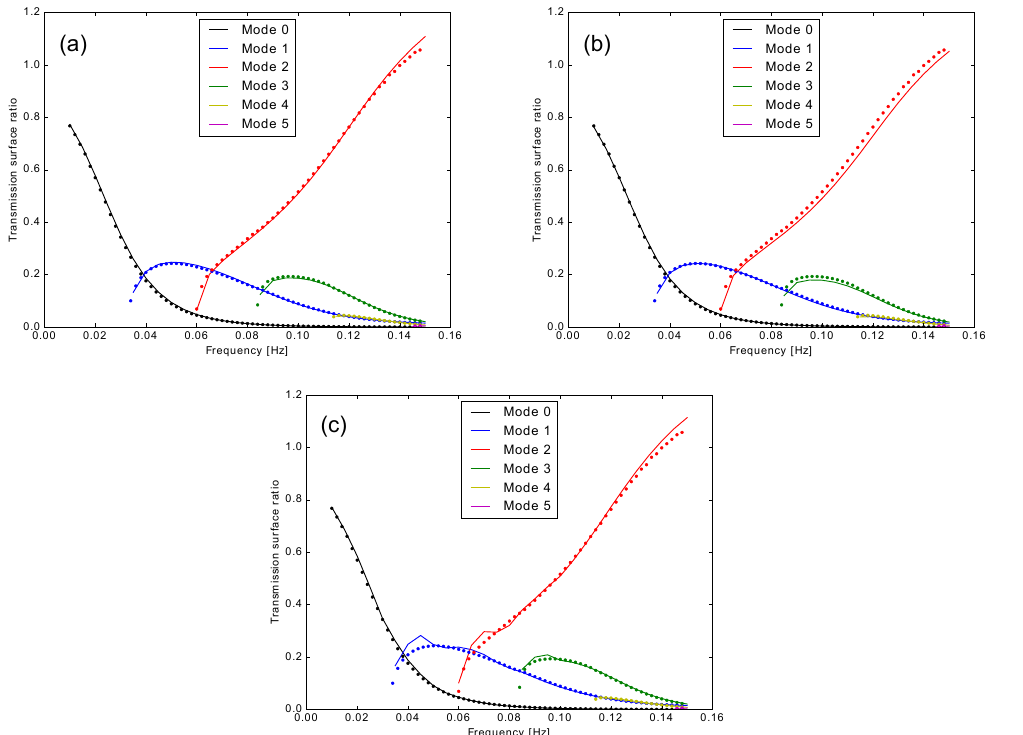
Figure 3. Transmission surface ratios obtained from the SWRT code (solid lines) and FD calculations (dots), for an incident Love wave fundamental mode propagating through the modified model L in the forward direction. (a) Using the GAl method; (b) using the GF method; (c) using the Alsop method. Note that the FD results are the same in all three plots. The last plot (c) is shown to highlight the weaker performance of the Alsop method (at the low-frequency end for the first and second higher modes), compared to the two methods which are the focus of this